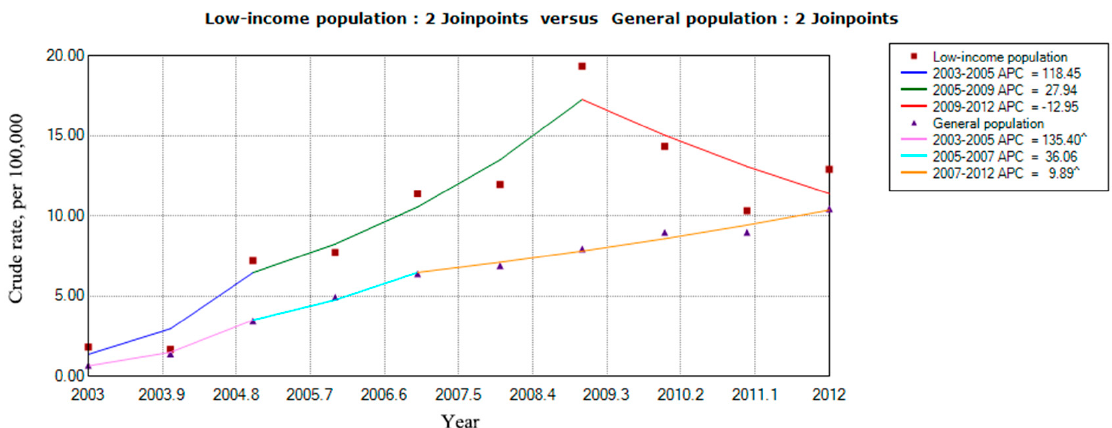
Figure 2. Comparison of the crude rates for the LIP and GP patients who underwent percutaneous cholecystostomy in Taiwan from 2003 to 2012.